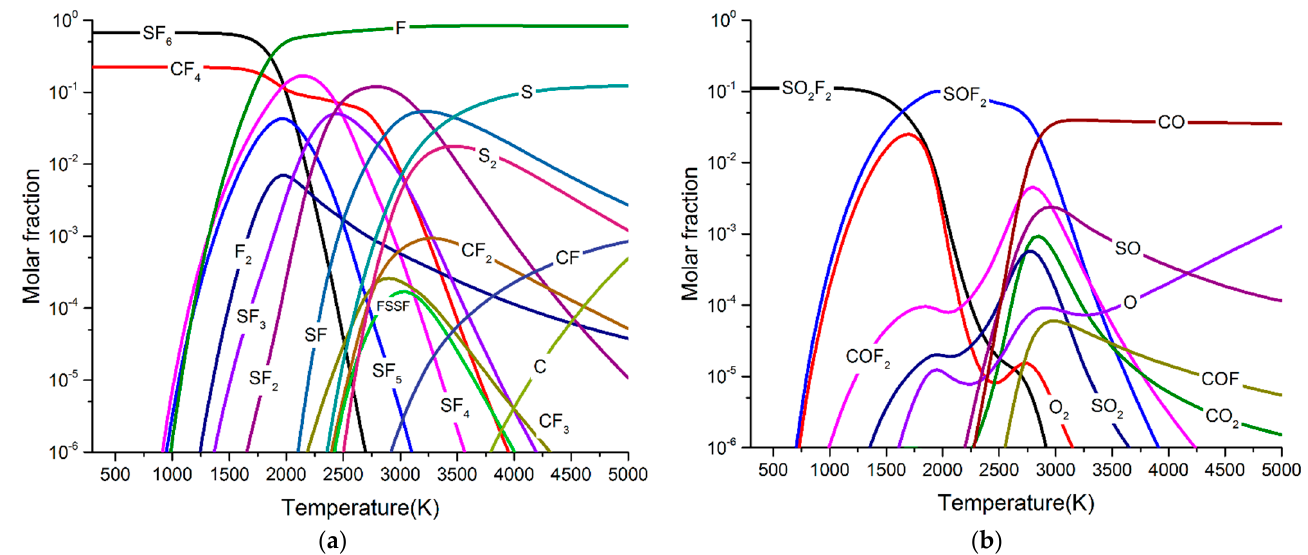
Figure 6. Particle composition of 70% SF 6 + 20% CF 2 + 10% O 2 arc plasma at 0.6 MPa. ( a ) SF 6 , SF 5 , SF 4 , SF 3 , SF 2 , SF, S, S 2 , F, F 2 , FSSF, CF 4 , CF 3 , CF 2 , CF, and C particles. ( b ) SOF 2 , SO 2 F 2 , COF 2 , COF, O 2 , O, SO 2 , SO, CO 2 , and CO particles.